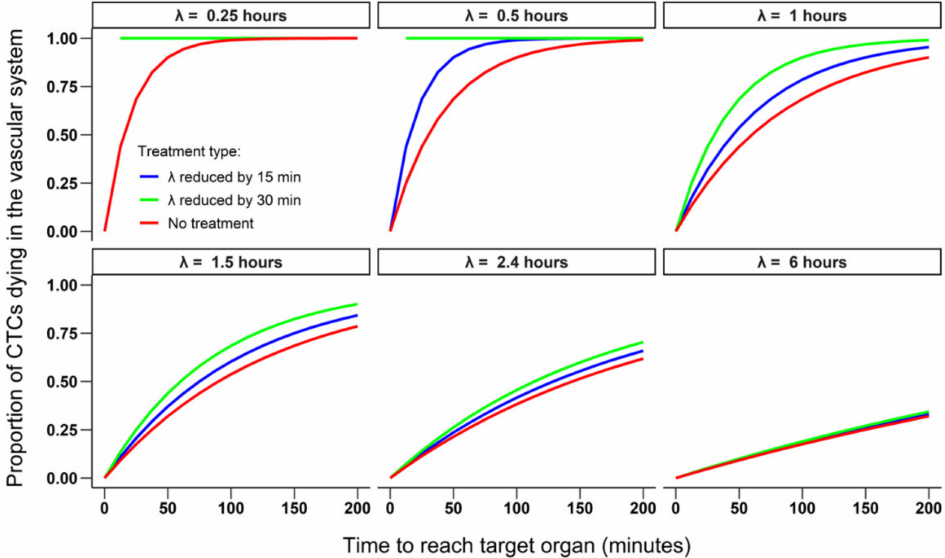
Figure 4. The effect of a hypothetical treatment on the proportion of CTCs dying in the vascular system as function of their half-life (initially ranging from 0.25 to 6 h) and the time required to reach the target organ. The red lines correspond to mortality calculated from simulations in which no treatment was applied, the blue lines from simulation in which the half-life was reduced by 15 min and the green lines from simulation in which the half-life was reduced by 30 min. The values for M, Pe and the number of shed cells are the same as in Figure 2. Note that in the simulation with a half-life of 0.25 h, the green line (half-life reduced by 30 min) overlaps the blue line (half-life reduced by 15